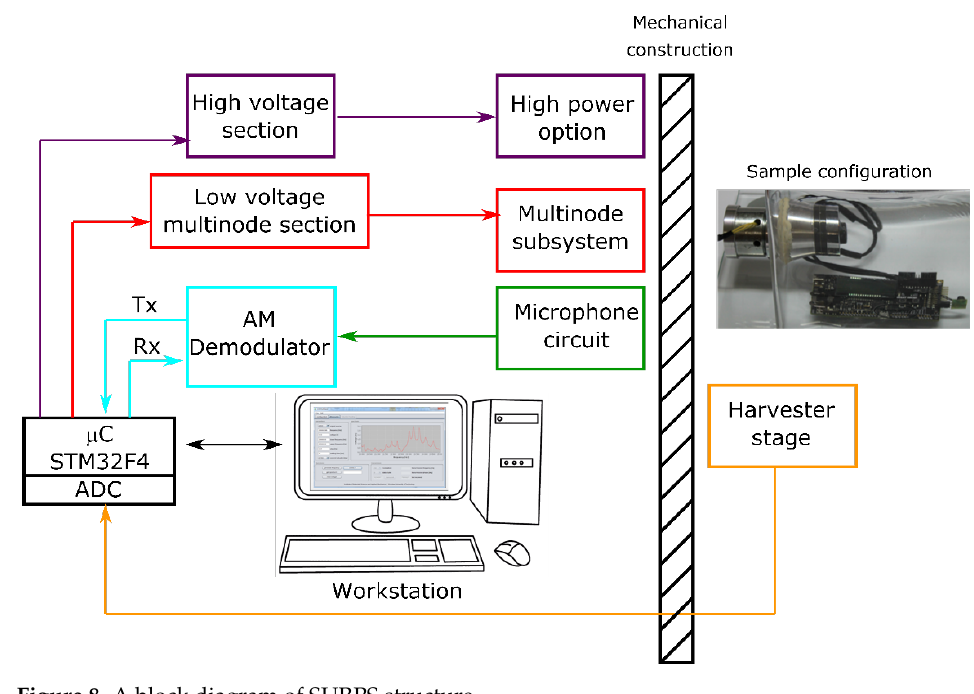
Figure 8. A block diagram of SURPS structure.